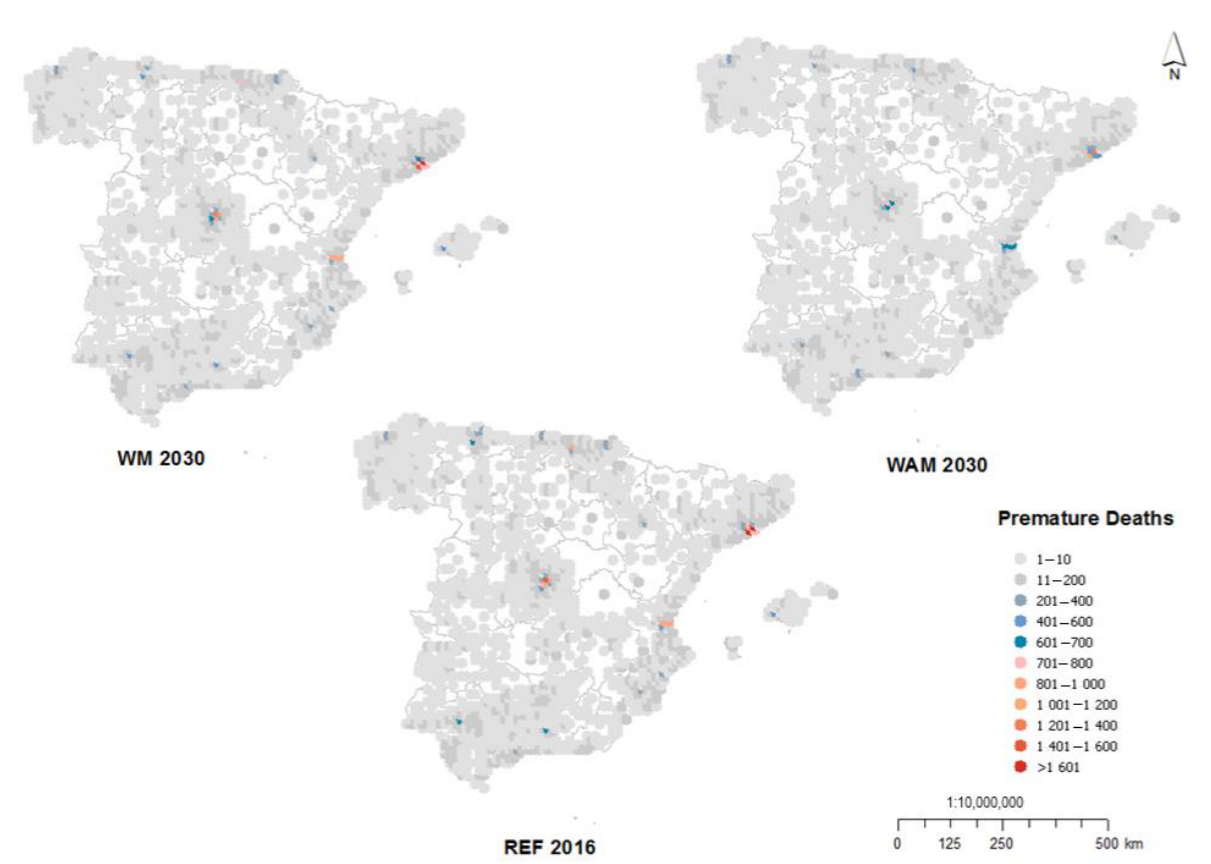
Figure 4. Spatial distribution of all pollutant mortality (premature death) in terms over the reference scenario (REF 2016, year 2016) for the scenarios WM2030 (on the left) and WAM2030 (on the right).